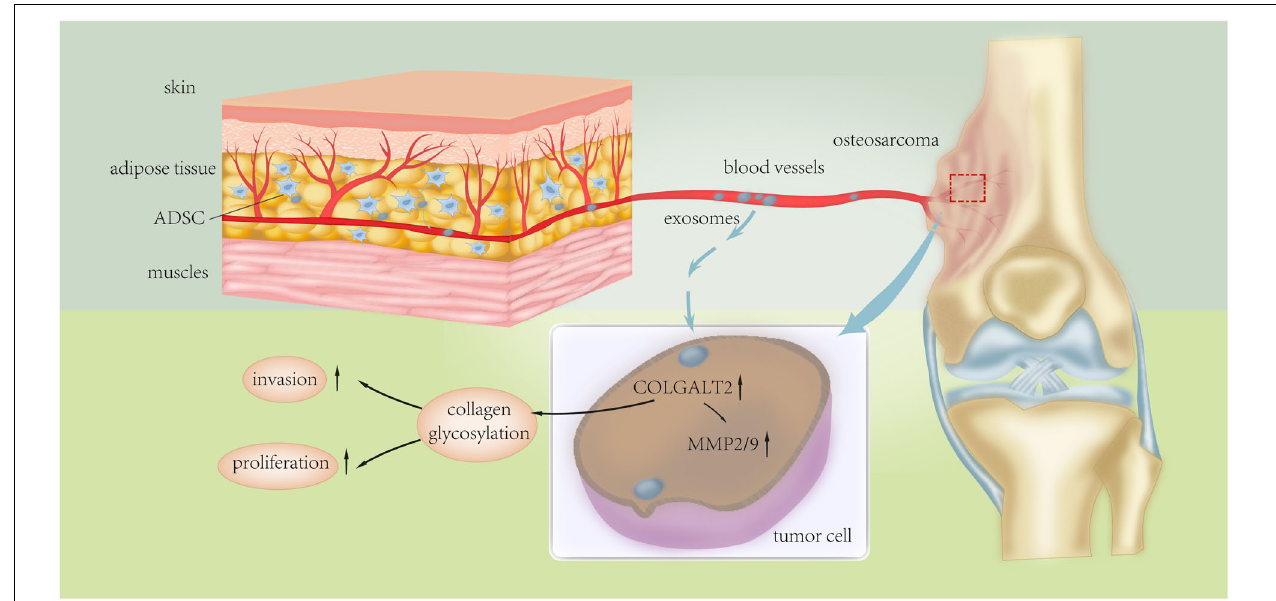
FIGURE 8 | Schematic presentation of the mechanism underlying ADSC exosomes-facilitated osteosarcoma proliferation and